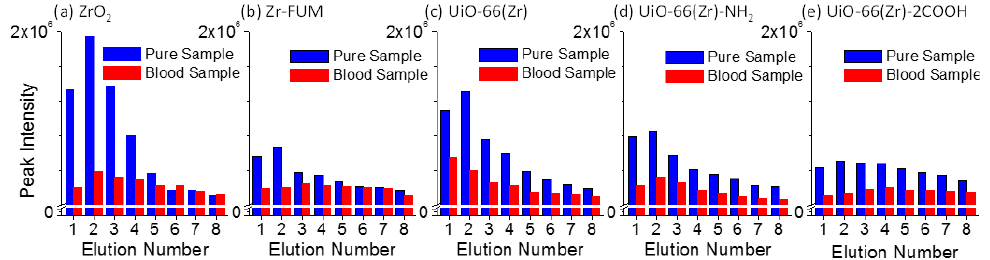
Figure 3. Comparison of the elution behaviors of verapamil samples (Pure Sample: 2 µ L of 1:1 methanol/water with 1.0 µ g mL − 1 of verapamil; Blood Sample: 2 µ L of blood sample with 1.0 µ g mL − 1 of verapamil) deposited onto the surfaces of various Zr-based material-coated papers: ( a ) ZrO 2 -coated paper, ( b ) Zr-FUM-coated paper, ( c ) UiO-66(Zr)-coated paper, ( d ) UiO-66(Zr)-NH 2 -coated paper, and ( e ) UiO-66(Zr)-2COOH-coated paper ( Note : The experiments were carried out after the paper had dried. Solvent: 25 µ L acetonitrile for each run; Voltage: 3.5 kV).